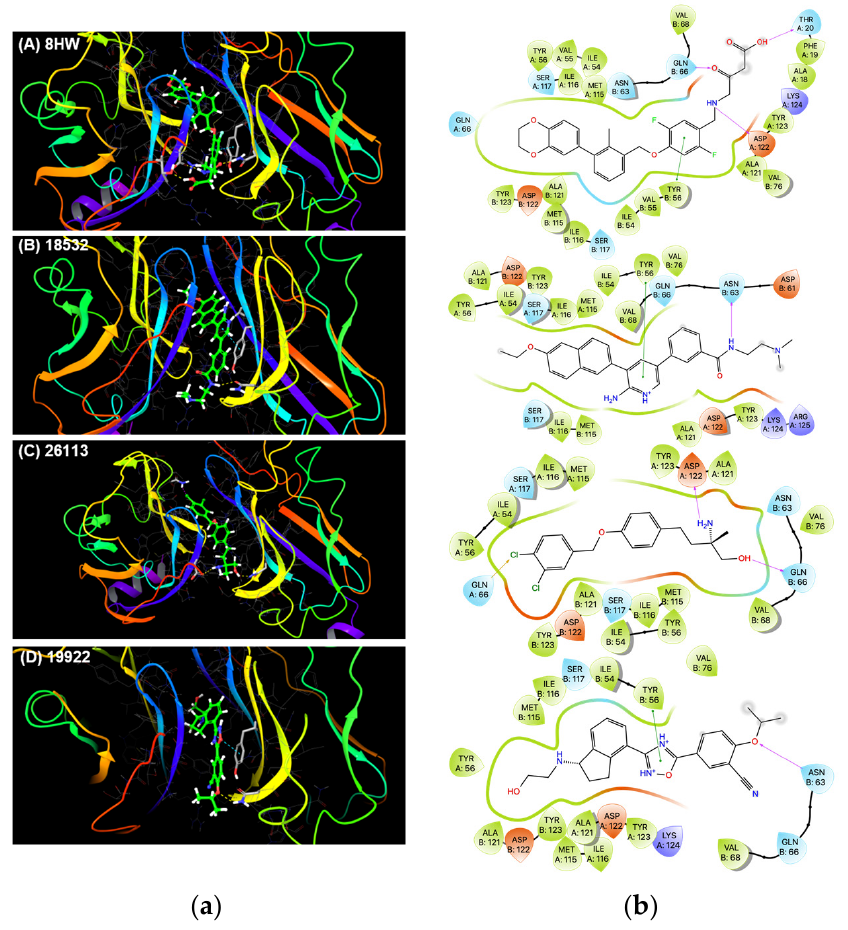
Figure 2. The PDL1 dimer binding modes of crystal ligand (8HW) and three hits (18532, 26113, and 19922) predicted by AutoDock Vina: ( a ) Representation of PDL1 dimer pockets containing bound ligands; and ( b ) 2D ligand–protein interactions.